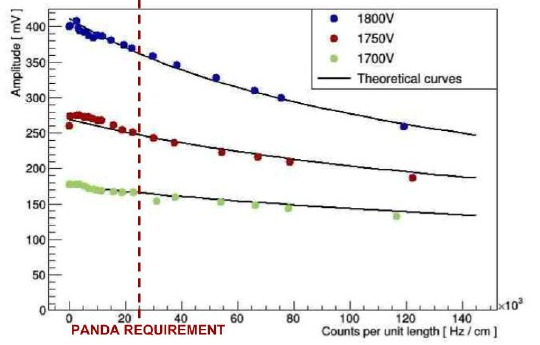
Figure 2: Amplitude of straw tube pulses as a function of counts per unit length of straw tube, mea- sured for three voltages of the anode wire. The highest rate per unit length expected in the PANDA FT is indicated by the red dashed line. Solid black lines represent calculation explained in the